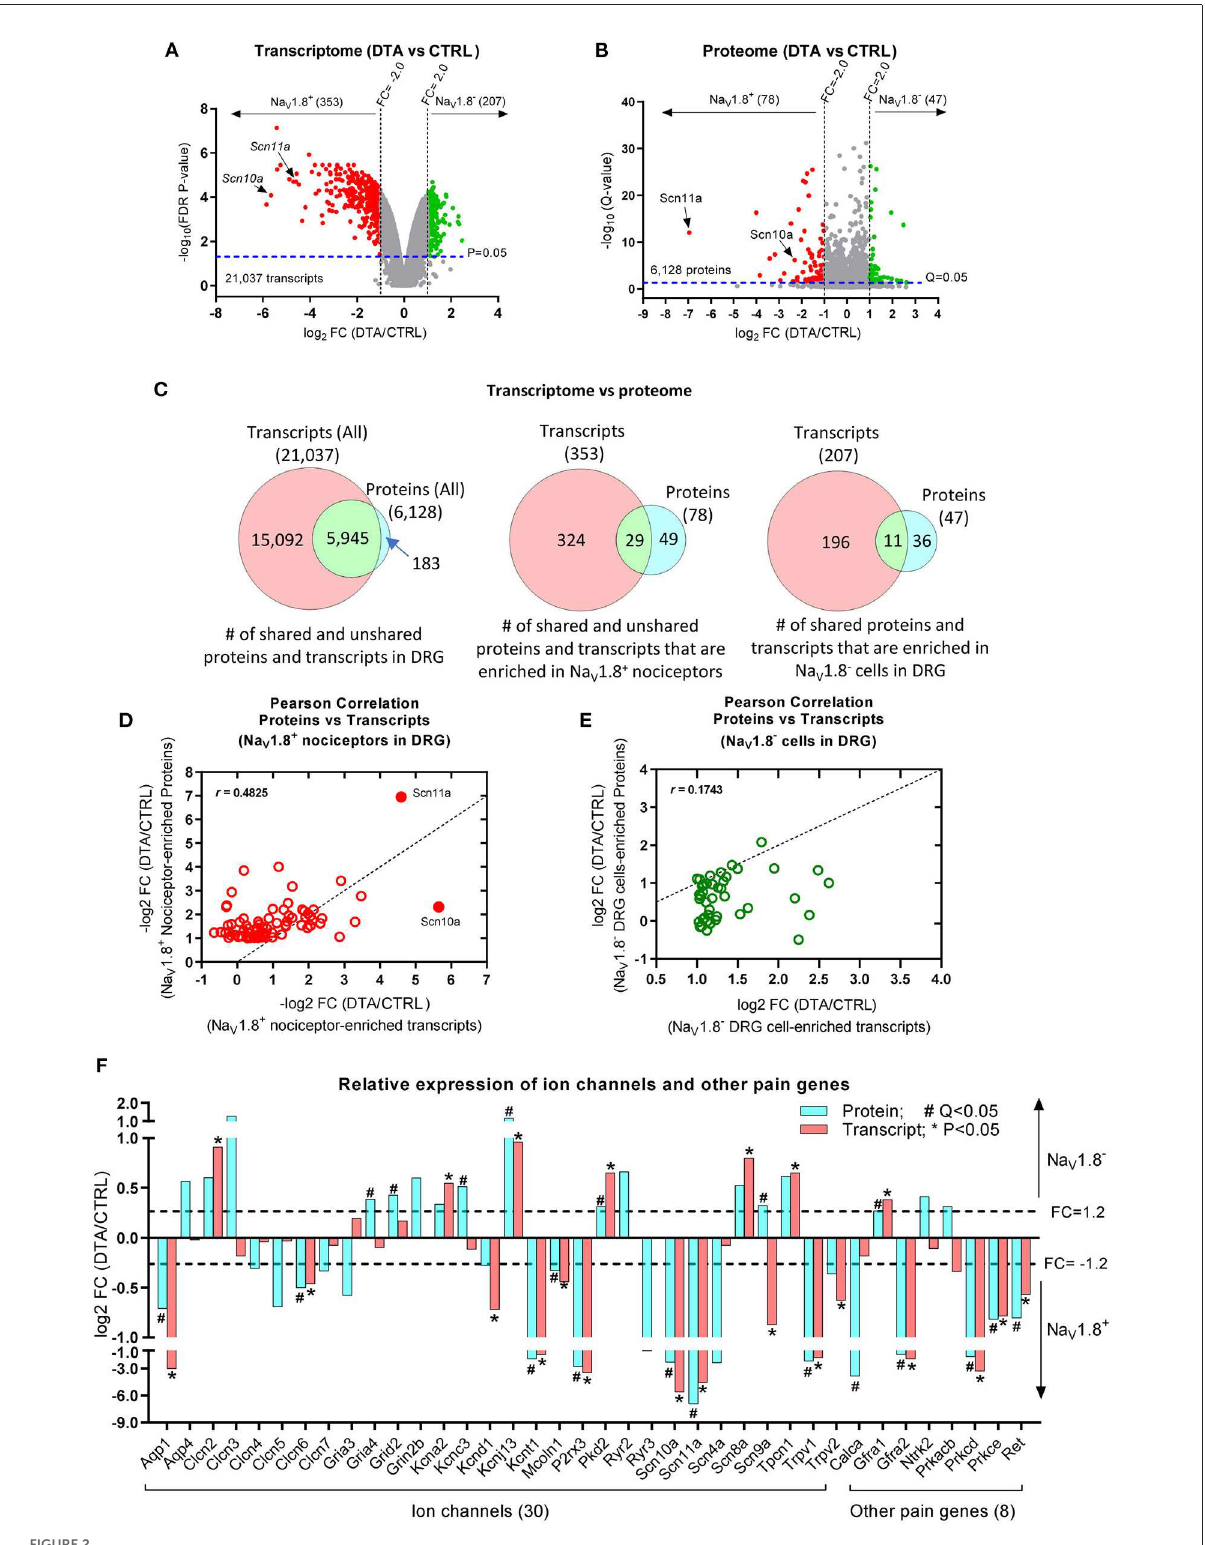
FIGURE2 Comparison of the transcriptome and proteome. (A) Volcano plot shows the average fold-change (log 2 FC) in expression levels of transcripts vs. FDR P -values (log 10 FDR P -value). Results are filtered by FC: FC < − 2.0, red dots; FC > 2.0, green dots; all with FDR P- value < 0.05 as indicated by the dashed line. (B) Volcano plot shows the average log 2 FC in relative protein abundance vs. Q -values (log 10 ; P -values corrected for